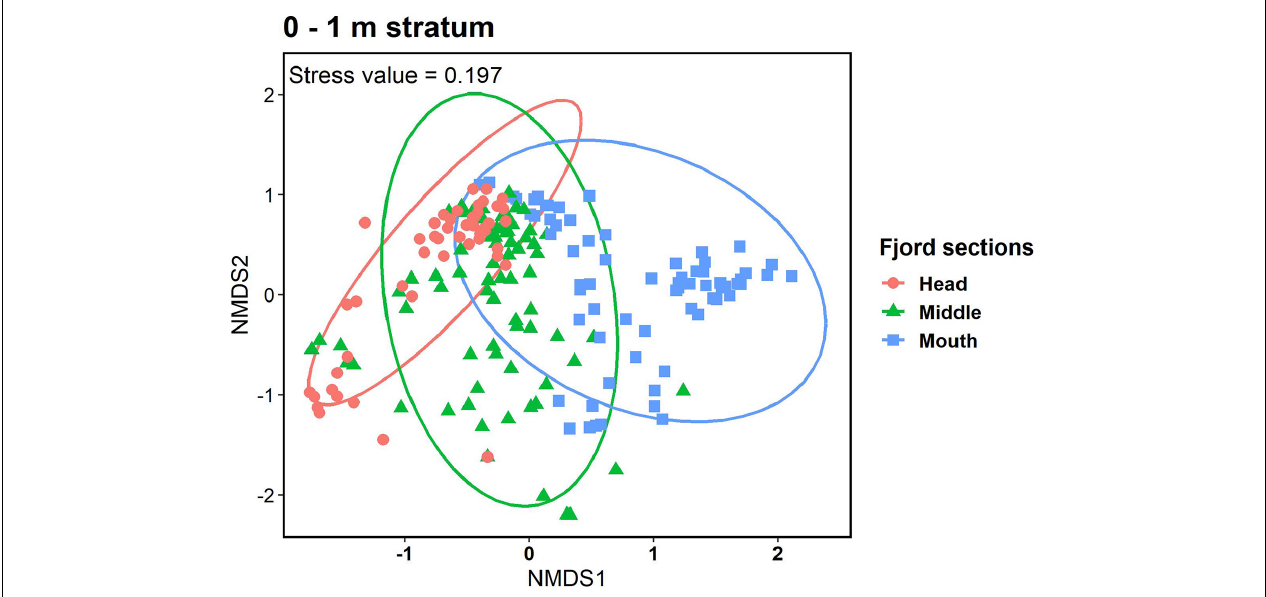
FIGURE 6 | Non-metric Multidimensional Scaling (NMDS) ordination plot of the observational units based on Bray-Curtis dissimilarities between fjord sections at 0–1 column water stratum of Comau